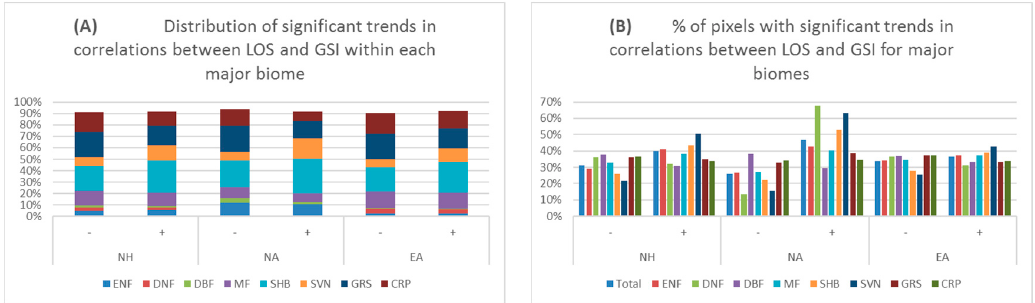
Figure 8. ( A ) Distribution of pixels with significant trends in correlations between LOS and GSI from